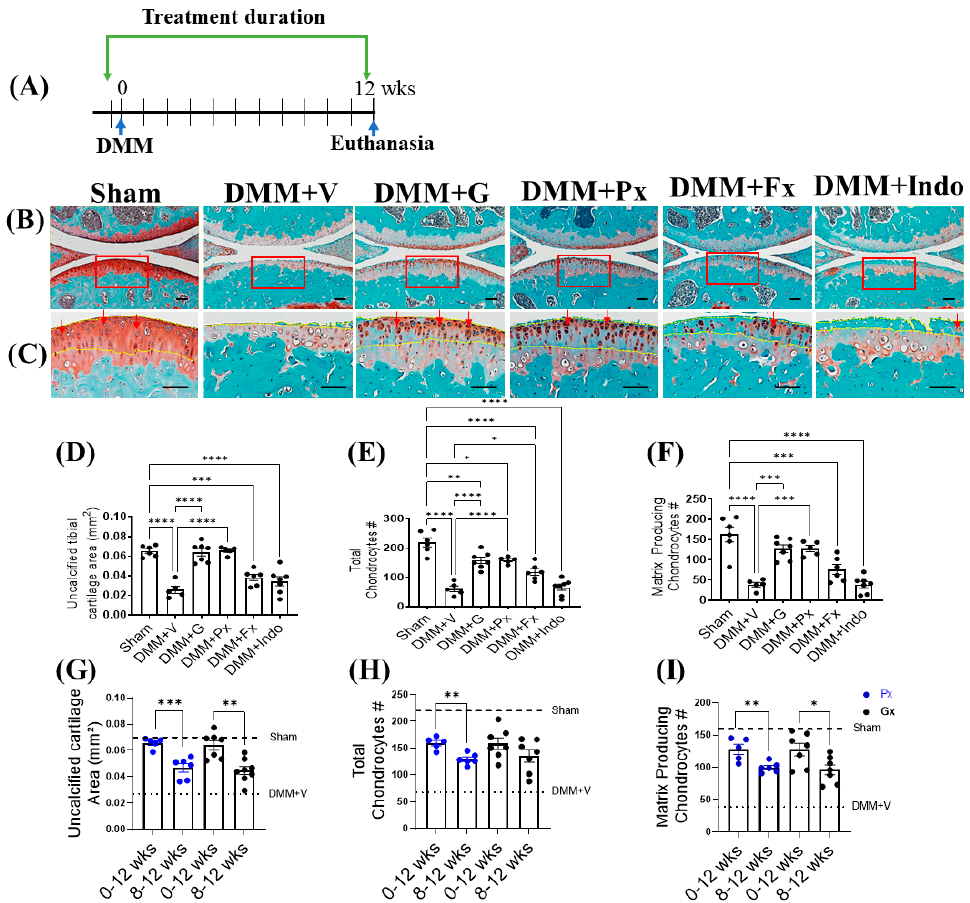
Figure 1. Early continuous G βγ -GRK2 inhibition prevents PTOA development in mice. ( A ) Schematic representation of timeline of drug treatment after sham ( n = 5) or DMM surgeries: Two days before surgery, mice started receiving daily intraperitoneal injections of vehicle (V; n = 5), gallein (G; 10 mg/kg per day, n = 7), paroxetine (Px; 5 mg/kg per day, n = 5), fluoxetine (Fx; 5 mg/kg per day, n = 6), or indomethacin (Indo; 2.5 mg/kg per day, n = 7). All mice were euthanized 12 weeks after surgery. Green arrows denote the duration of drug treatment. ( B ) Representative images of Safranin-O/Fast-Green-stained knee joints; scale bar, 100 µm. ( C ) Magnified images of regions marked by red boxes in ( B ); scale bar, 50 µm. Arrows indicate representative anabolic matrix-producing chondrocytes (dark-red color). Yellow dotted line indicates uncalcified cartilage area in ( C ). Histomorphometric analyses of all treatment groups, showing changes in ( D ) uncalcified cartilage area, ( E ) total chondrocyte number, and ( F ) matrix-producing chondrocyte number. ( G – I ) Histomorphometric analyses comparing early and delayed continuous gallein (black color points) and paroxetine (blue color points) treatment groups (0–12 weeks and 8–12 weeks post-DMM), showing changes in ( G ) uncalcified cartilage area, ( H ) total chondrocyte number, and ( I ) matrix-producing chondrocyte number. * p < 0.05, ** p < 0.01, *** p < 0.001, and **** p < 0.0001 using one-way ANOVA. * p < 0.05, ** p < 0.01, and *** p < 0.001 0–12 weeks vs. 8–12 weeks treatment groups using Welch’s t -test. Values are expressed as means ±